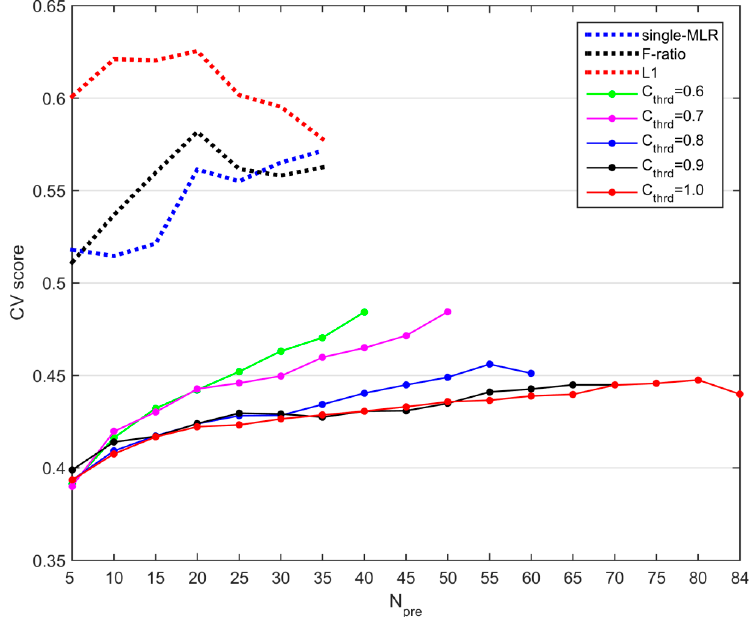
Figure 8. The repeated 10-fold CV scores (valid line) for MLR models with randomly-selected predictors dependent on different N pre s and C thrd s. The CV scores of the objective prediction model (dashed line; refers to Figure 5) are shown for comparison.